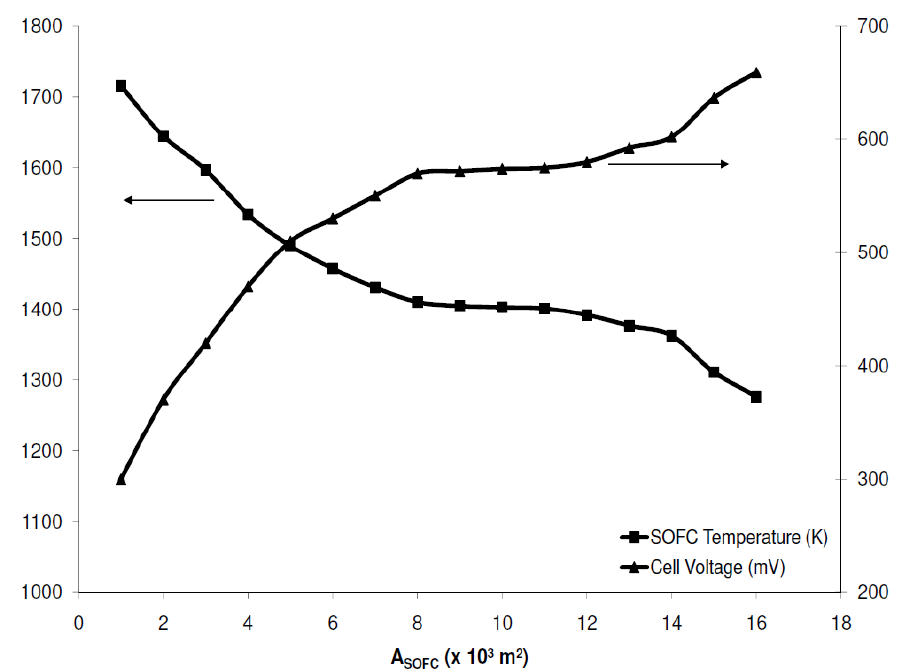
Figure 7. SOFC temperature and voltage versus SOFC area.